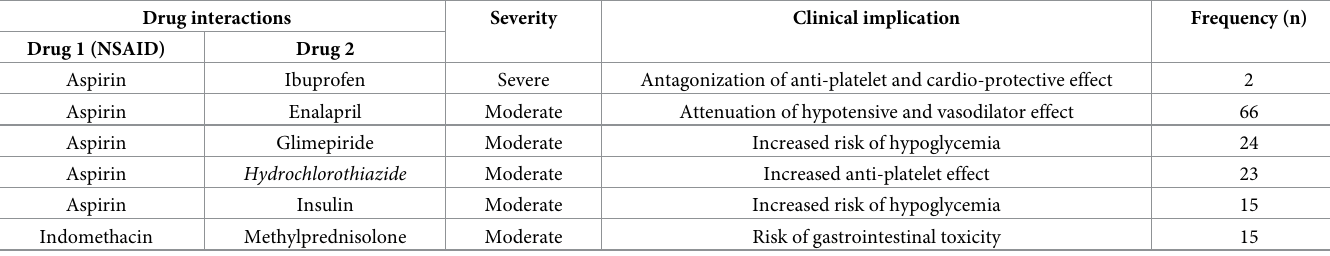
Table 5. Most common potential drug interactions with their severity and clinical implications.